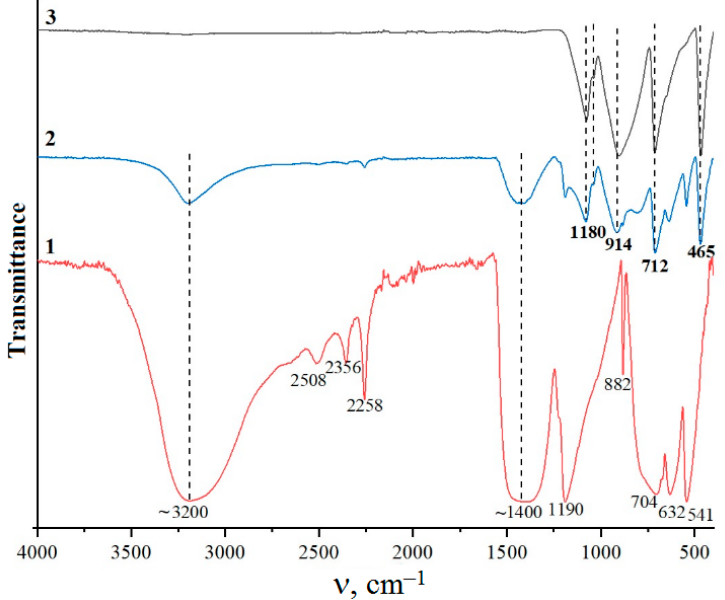
Figure 5. X-ray powder diffraction patterns of samples 3 (curve 3), 4 (curve 2), and 5 (curve 3).